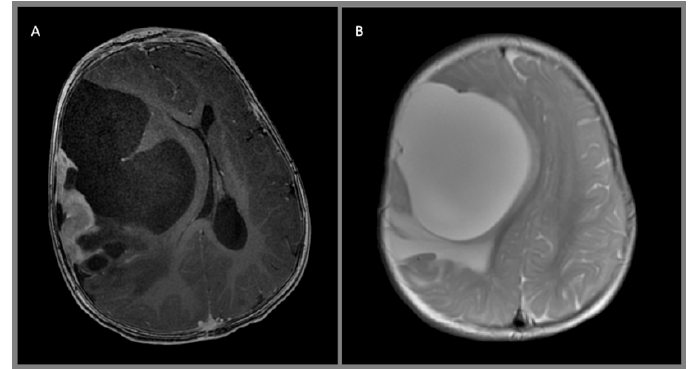
Figure 4. Desmoplastic infantile ganglioglioma, WHO I: ( A ) axial T1 MPRAGE contrast enhanced and ( B ) axial T2 images demonstrate a large right frontoparietal mass with a large cystic component and a superficial enhancing nodule with adjacent perilesional parenchymal edema.